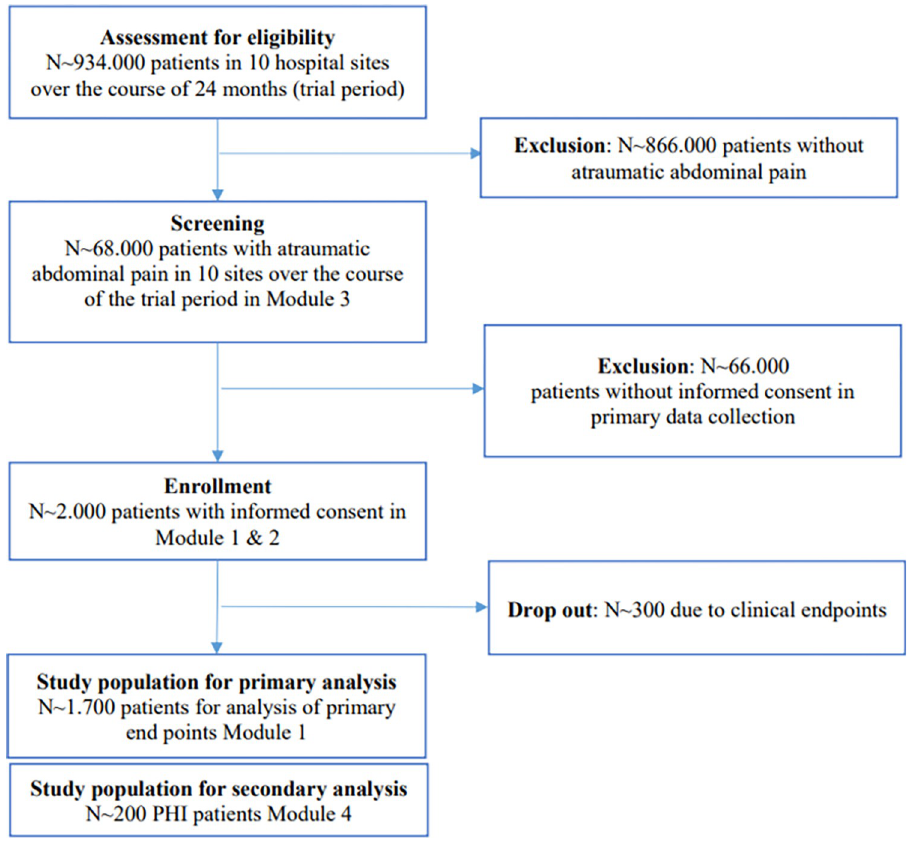
Fig 3. Flow chart of patients admitted to the participating 10 emergency departments in Germany and resulting study population with atraumatic abdominal pain.